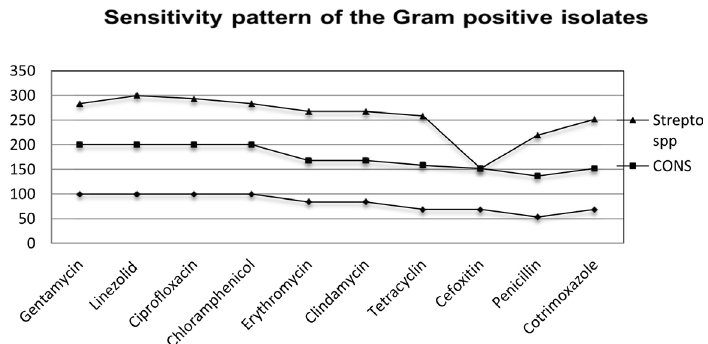
Fig. 2. Showing the Antibiotic Susceptibility pattern of the Gram Positive Bacteria